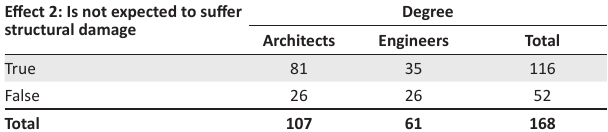
TABLE 9: Objective 4 of seismic rules (guarantee the safeguarding of all people). Objective4: Guarantee the safeguarding of all people